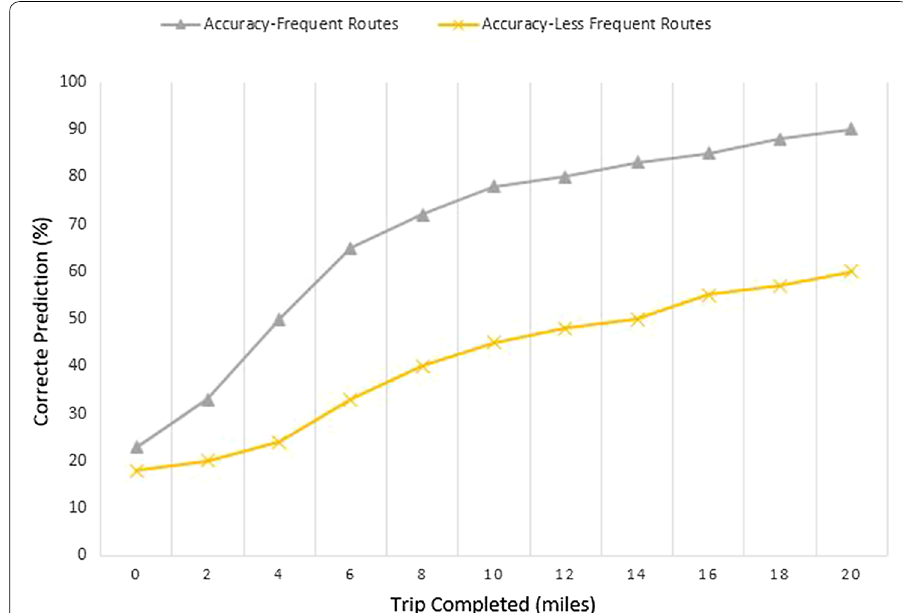
Fig. 13 Prediction accuracy in terms of miles of trip completed